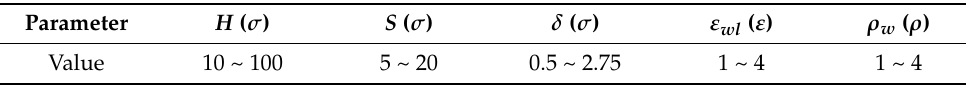
Table 1. Simulation parameters of the wall geometry, roughness, and energy.